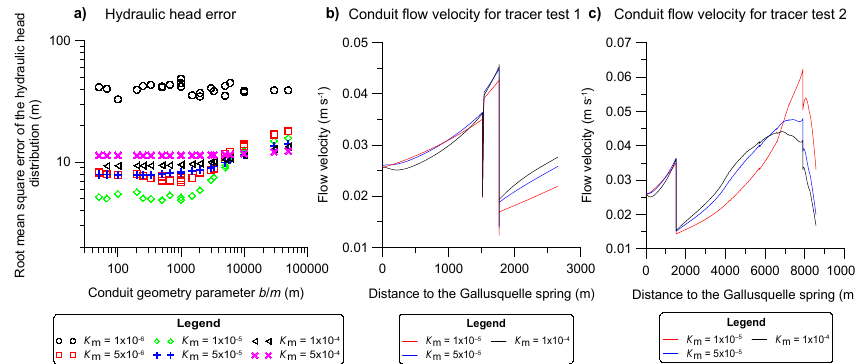
Figure 4. Influence of the hydraulic conductivity of the fissured matrix on the objective functions. (a) Influence on the root mean square error of the hydraulic head distribution in relation to the conduit geometry. The conduit geometry is represented by the parameter b/m (Eq. 1), which is the ratio of the smallest radius to the slope of radius increase along the conduit length. (b) Influence on the conduit flow velocity for tracer test 1. (c) Influence on the conduit flow velocity for tracer test 2.